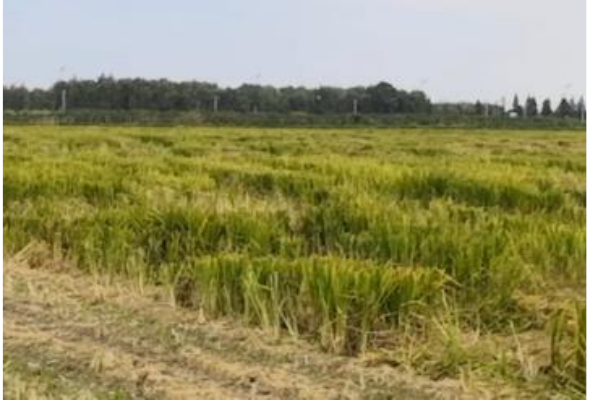
Figure 1. Primitive land with full rice straw in rice – wheat rotation area.